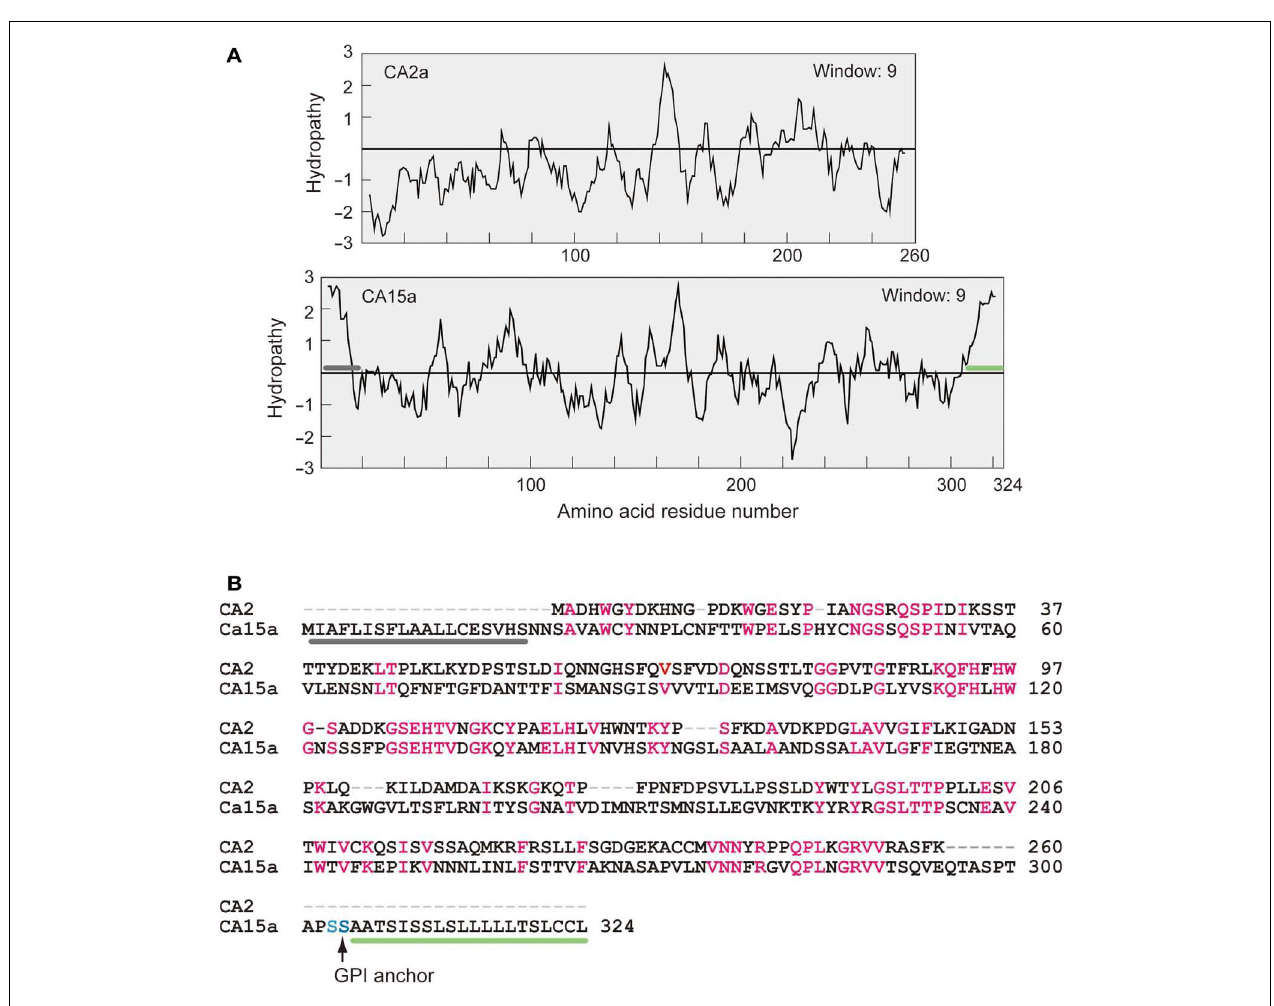
glycosylphosphatidylinositol (GPI)-anchor signal. (B) Comparison of amino acid sequences of zebrafish CA2a and CA15a. Identical residues are highlighted in red. GPI anchor site is indicated by a vertical arrow. Gray and green bars correspond to those in (A)